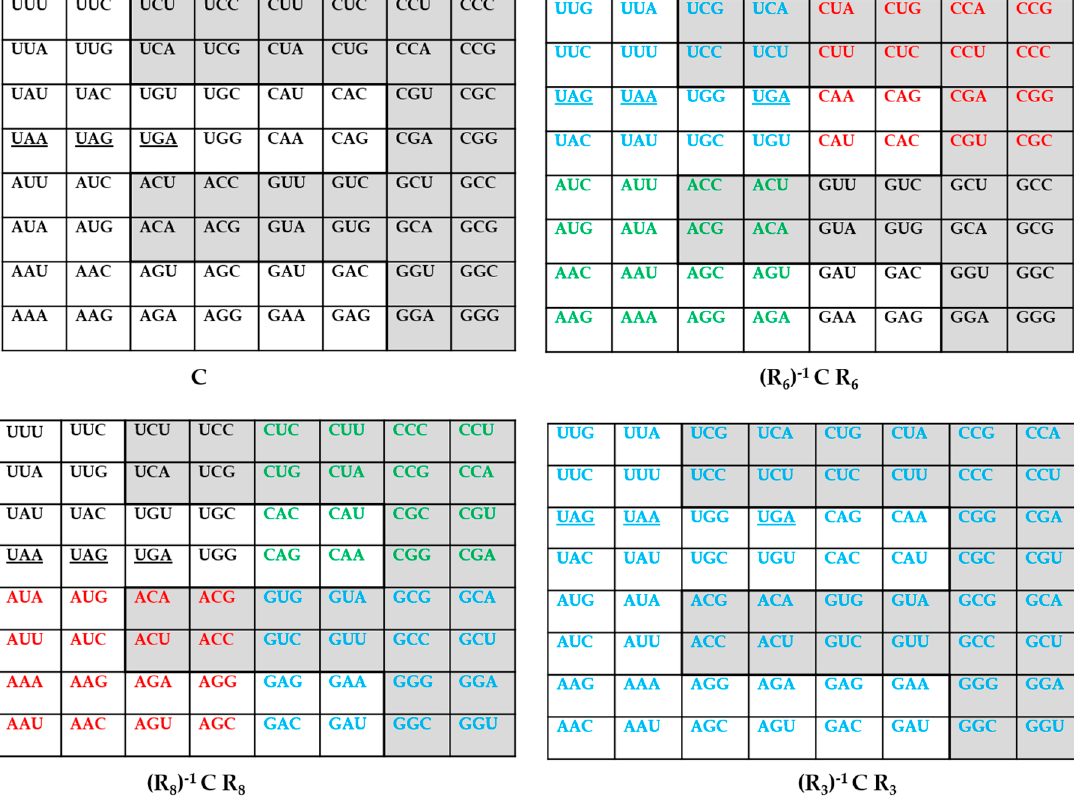
Figure 2. The action of the transformations R 3 , R 6 , and R 8 on the codon matrix C (see the text and [20]). The set M 1 is indicated in light grey, as in Figure 1. The blue color corresponds to the substitutions {U ↔ G, A ↔ C}, the red color to the substitutions {A ↔ U, C ↔ G} and the green color to the substitutions to {U ↔ C, A ↔ G}; all the substitutions occur at the third base. For R 6 and R 8 , the codons shown in black have their position strictly unchanged. The codons corresponding to the stop codons are underlined.